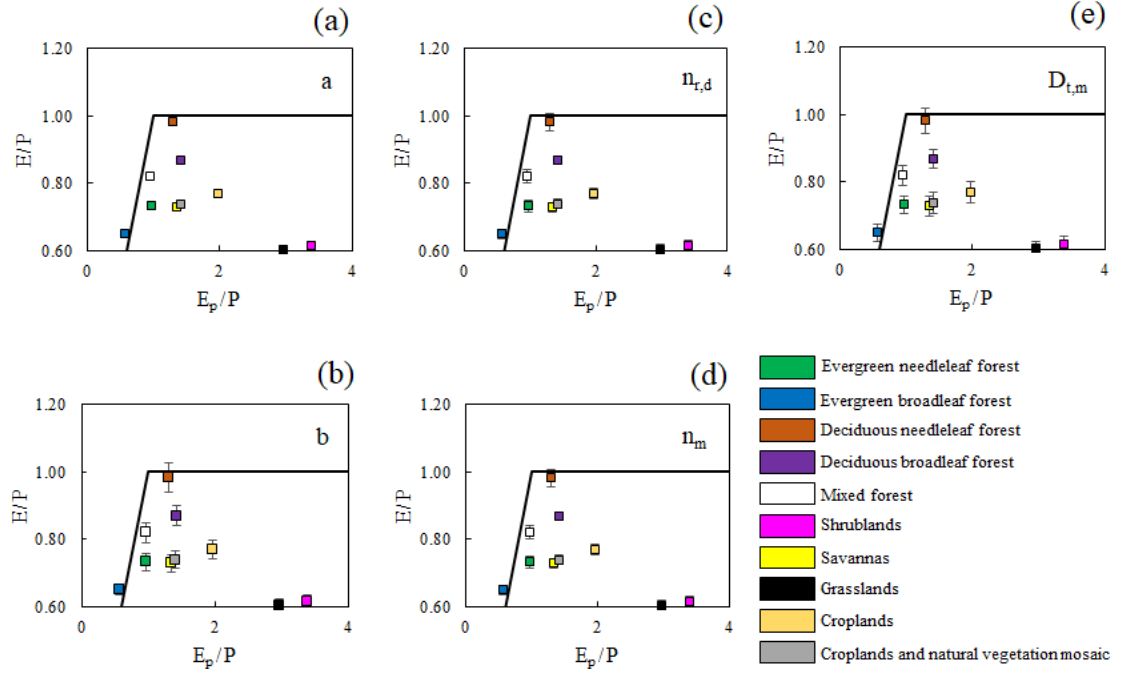
Figure 10. Sensitivity analysis of the model to 10% changes in (a) parameter a in Eq. (18), (b) parameter b in Eq. (8), (c) number of rain